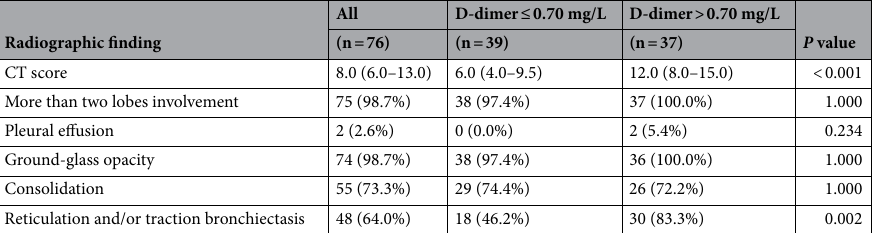
Table 2. Comparison of radiographic findings between patients with D-dimer ≤ 0.7 mg/L and > 0.7 mg/L. Data are expressed as counts and percentage. The Pearson Chi-square or Fisher’s Exact Test was used to test the difference between D-dimer groups, as appropriate. HRCT high resolution computed tomography.